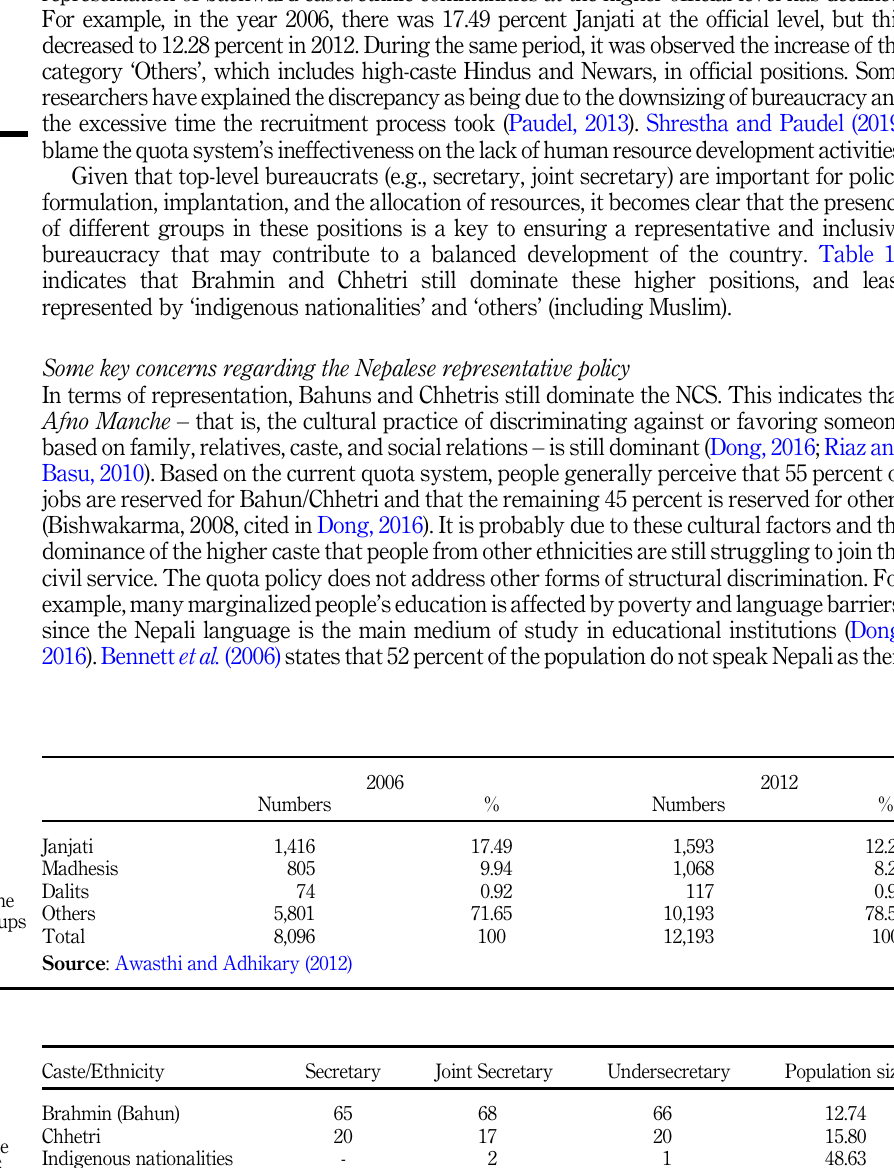
Table 11. Bureaucratic representation in the top level of the NCS, based on caste/ ethnicity. Percent